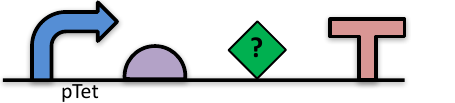
Figure 36: A functional unit consisting of promoter, ribosome entry site, CDS, and terminator, except that information about the CDS is missing, leaving it to fall back on the default unspecified glyph.